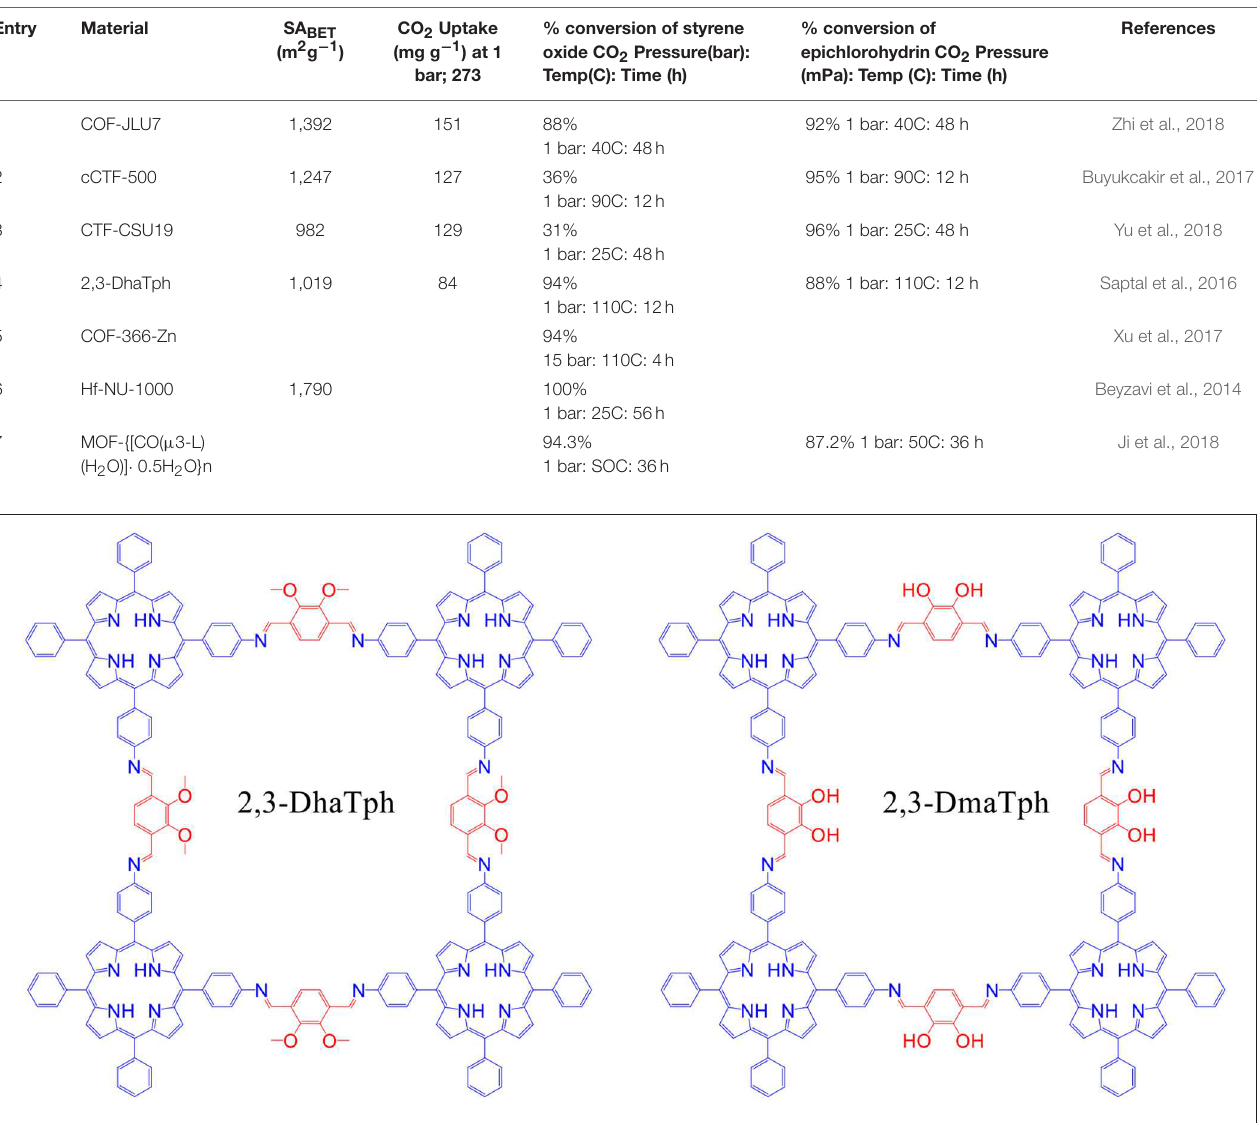
Using 2,3-DhaTph COF to describe the mechanism, Saptal et al. note that vicinal alcohol groups of the catechol linker increase polarization of the C-O bond through hydrogen bonding. The polar C-O bond is then attacked by the anionic halogen of the co-catalyst facilitating cycloaddition as seen in Figure 21 . As porous heterogeneous catalysts can be reused and recycled, cycloaddition reaction of SO to SC was used to investigate the recyclability of the COF catalyst. Sapatal et al. reported that the 2,3-DhaTph COF catalyst could be effectively reused with high catalytic